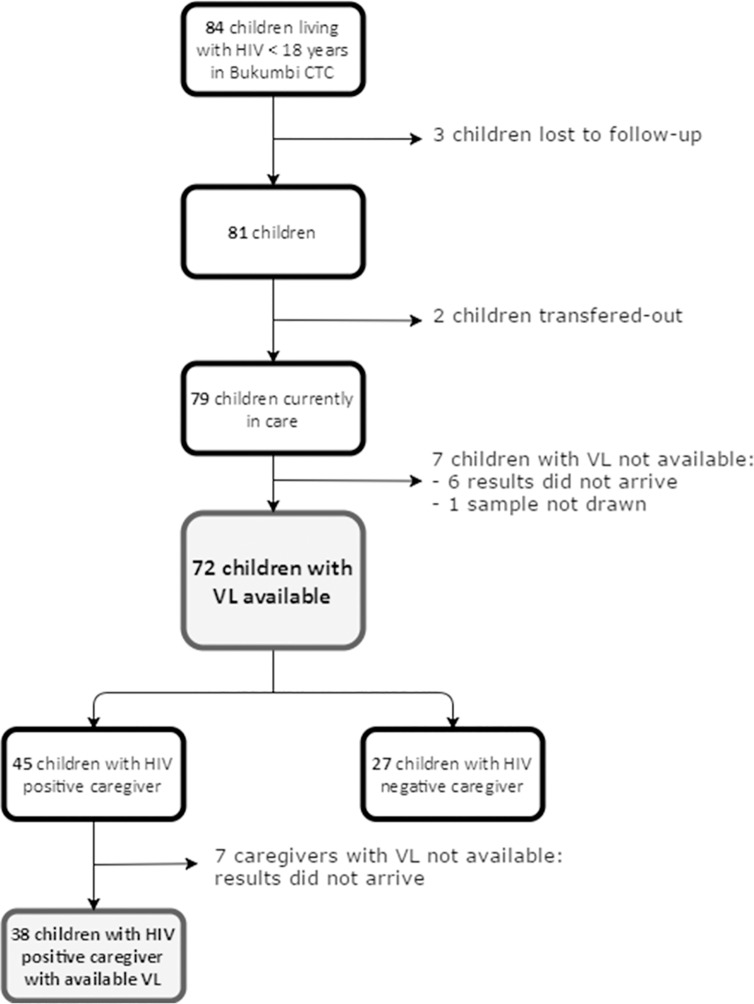
Flow diagram of enrolled population.CTC = Care and Treatment Clinic, VL = HIV viral load.